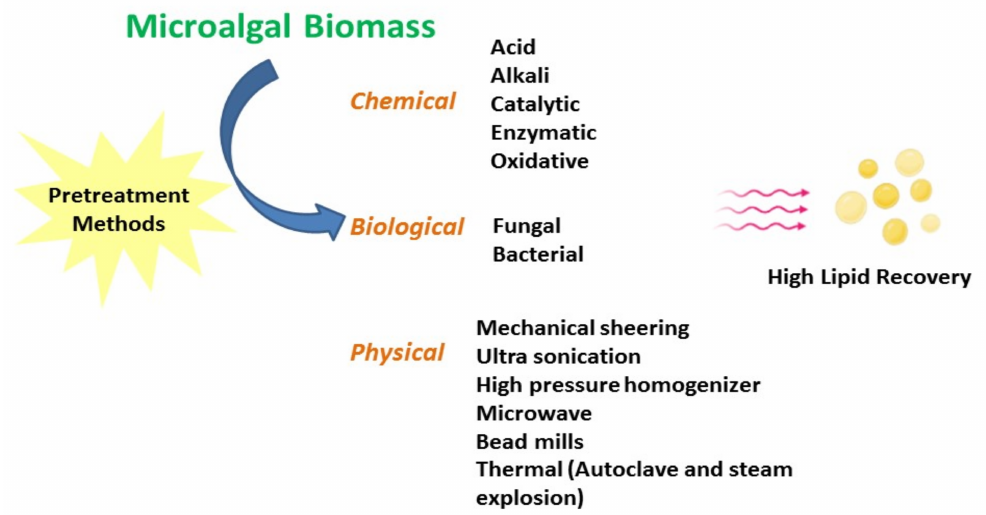
Figure 3. Different pretreatment methods for high lipid